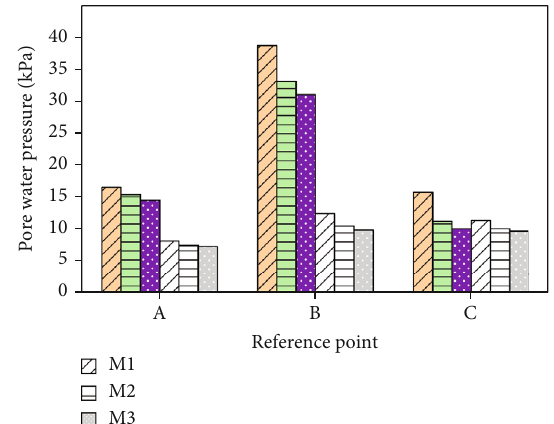
Figure 18: Di ff erent values of pore pressure at the reference points for di ff erent rooting